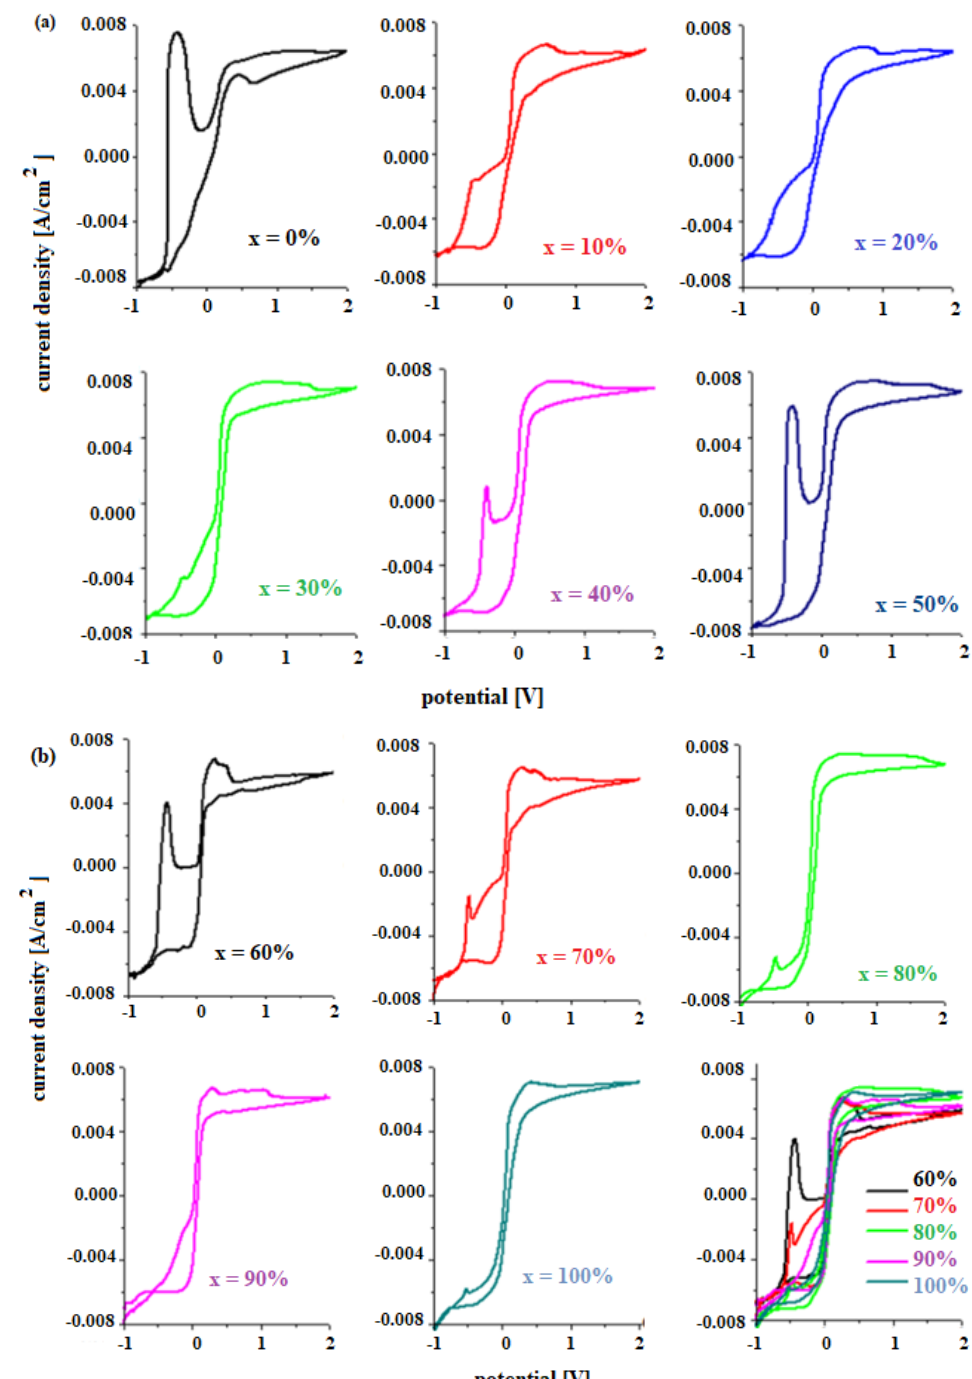
Figure 4. Cyclic voltammograms of the vitroceramics with chemical formula 15MnO 2 ∙ 85[(100 − x)PbO 2 ∙ xPb] where ( a ) x = 0–50 mol% Pb and ( b ) x = 60–100 mol% Pb. To describe the first oxidation peak in the anodic region, the cyclic voltammograms in the potential range − 0.75 V and − 0.25 V are presented in Figure 5a. For the undoped sample, the oxidation peak appears centered at − 0.46 V and has the highest intensity. This peak corresponds to an overlap of waves from the following redox systems: Pb/PbO (peak at about − 0.58 V), Pb/HPbO 2 − ( − 0.54 V) and Pb/PbSO 4 ( − 0.356 V) [13,14]. The existence of these redox processes implies the formation of a layer of PbO, HPbO 2 − , and PbSO 4 in the cathodic region, which minimizes the performance of the elec ‐ trode. By adding Pb content in the vitroceramic structure, the intensity of the anodic peaks decreases. For % Pb, the descending order is: 50% > 60% > 40% > 70% > 80% > 10% > 30% > 100% Pb. The lower intensities of the anodic peaks were observed for the samples with x = 10, 20, 30, 90, and 100% Pb. In the area with positive current density, there are low ‐ intensity oxidation peaks cen ‐ tered at +0.28 V, +1.22 V, and 1.60 V that correspond to the following redox processes PbO 2 /Pb (+0.28 V), O 2 /H 2 O (1.22 V), PbO 2 /Pb (1.455 V), and Mn +3 /Mn +2 (1.54 V). These peaks are responsible for the improved current density in the potentials situated between 0 and 2 V. The reduction peaks located at about 0.28 V, − 0.126 V, and − 0.345 V are well defined for the sample with x = 60 mol% Pb. This trend in redox processes suggests that thee redox couples do not produce completely different reactions.